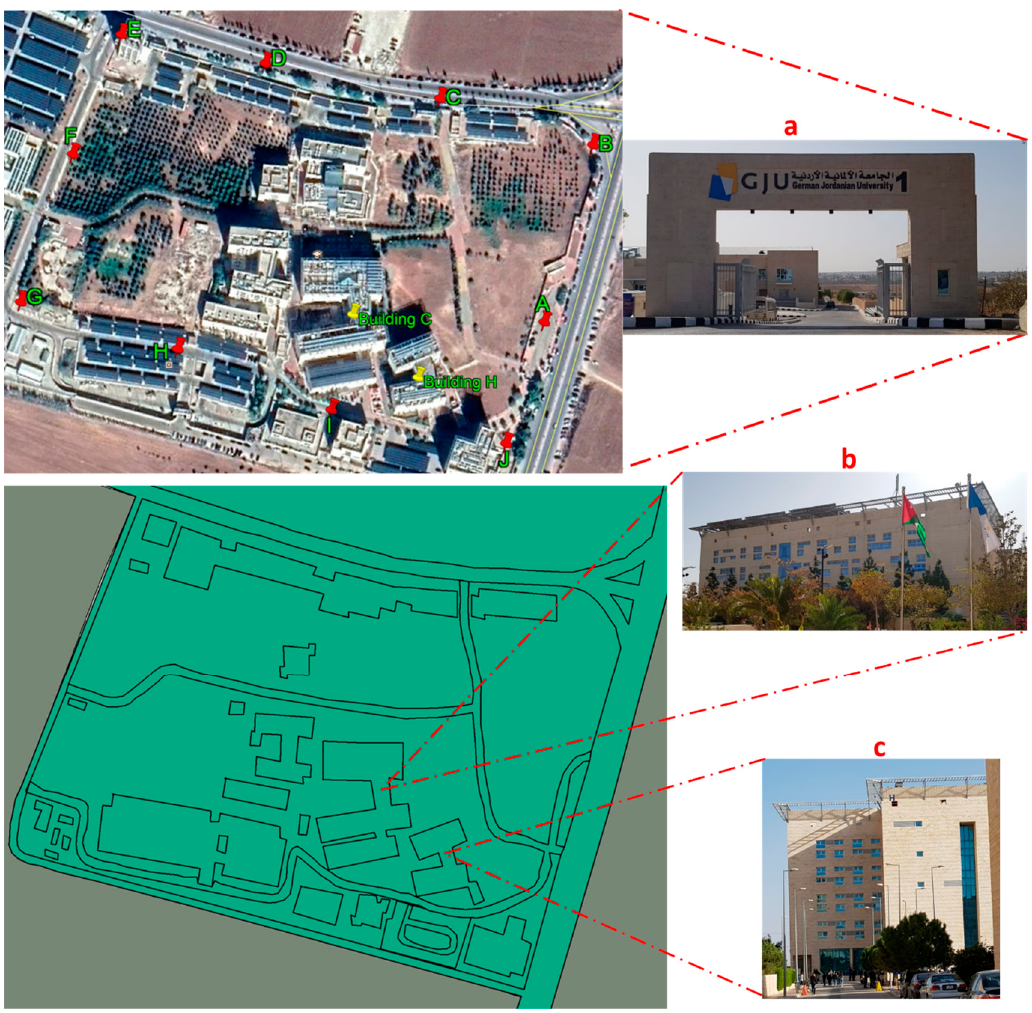
Figure 2. Map of the university area of GJU and measured buildings. ( a ) GJU, ( b ) building C and ( c ) building H.